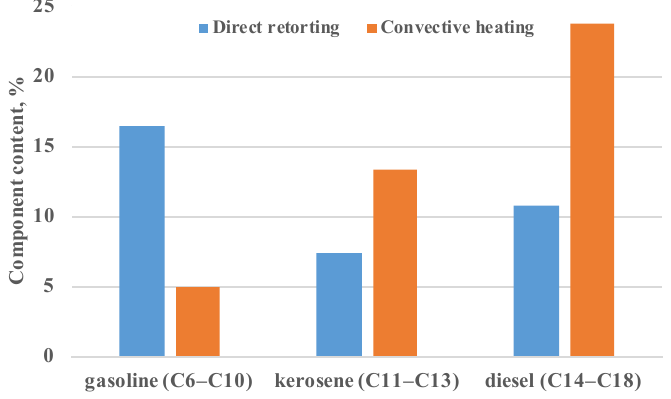
Fig. 6. Comparison of light components in shale oil under different heating